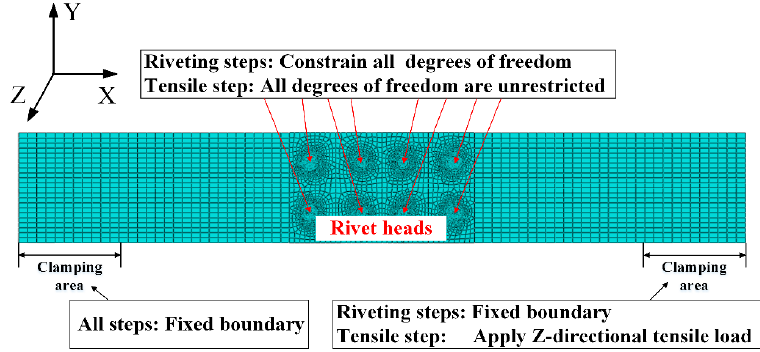
Figure 8. The boundary conditions in the FE model.